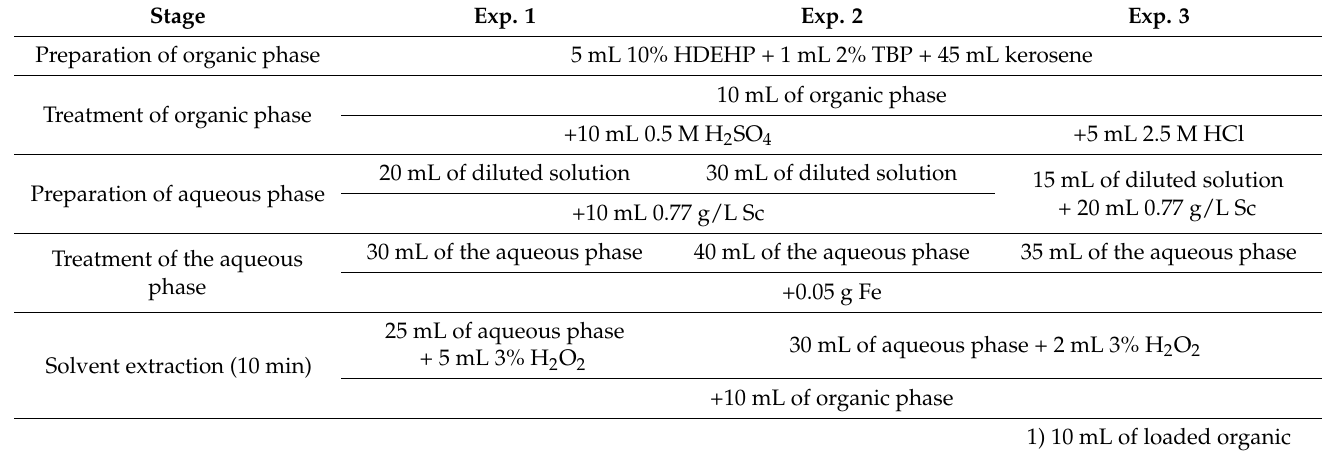
Table 2. Stages of solvent extraction experiments for scandium